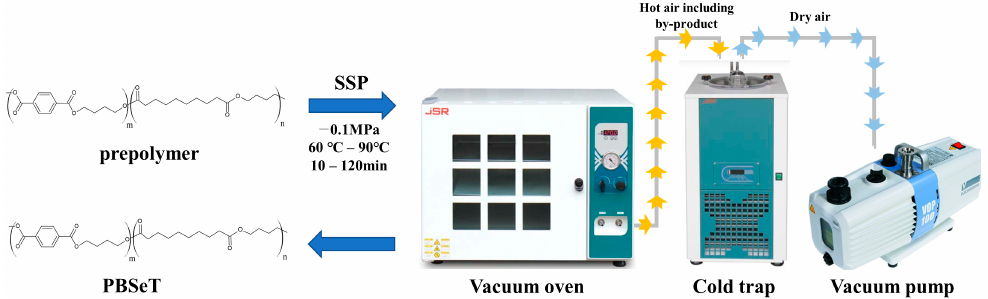
Figure 2. Process of SSP for PBSeT.